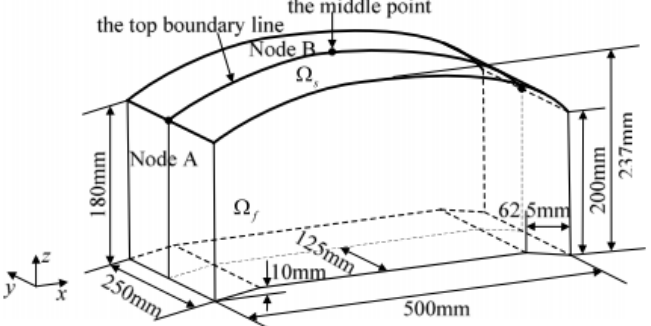
Figure 4. Schematic of a structural-acoustic model.